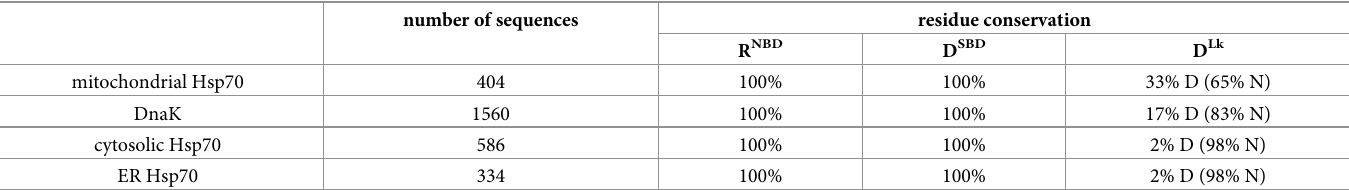
Table 1. Evolutionary conservation of R NBD -centered interaction